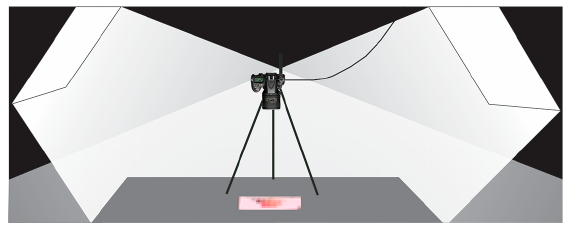
Figure 3. Photo studio setting.